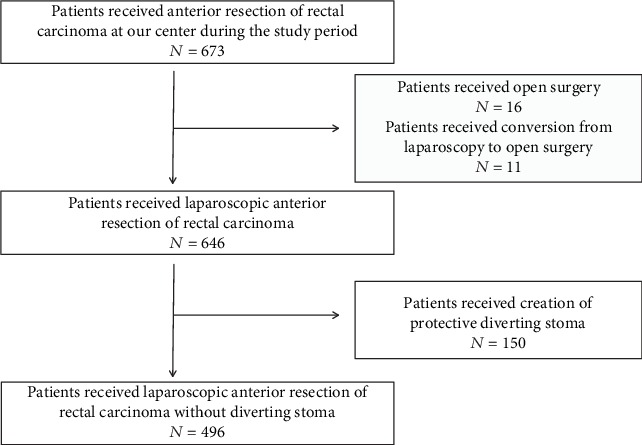
Flow chart presenting the patients' enrollment in our study.